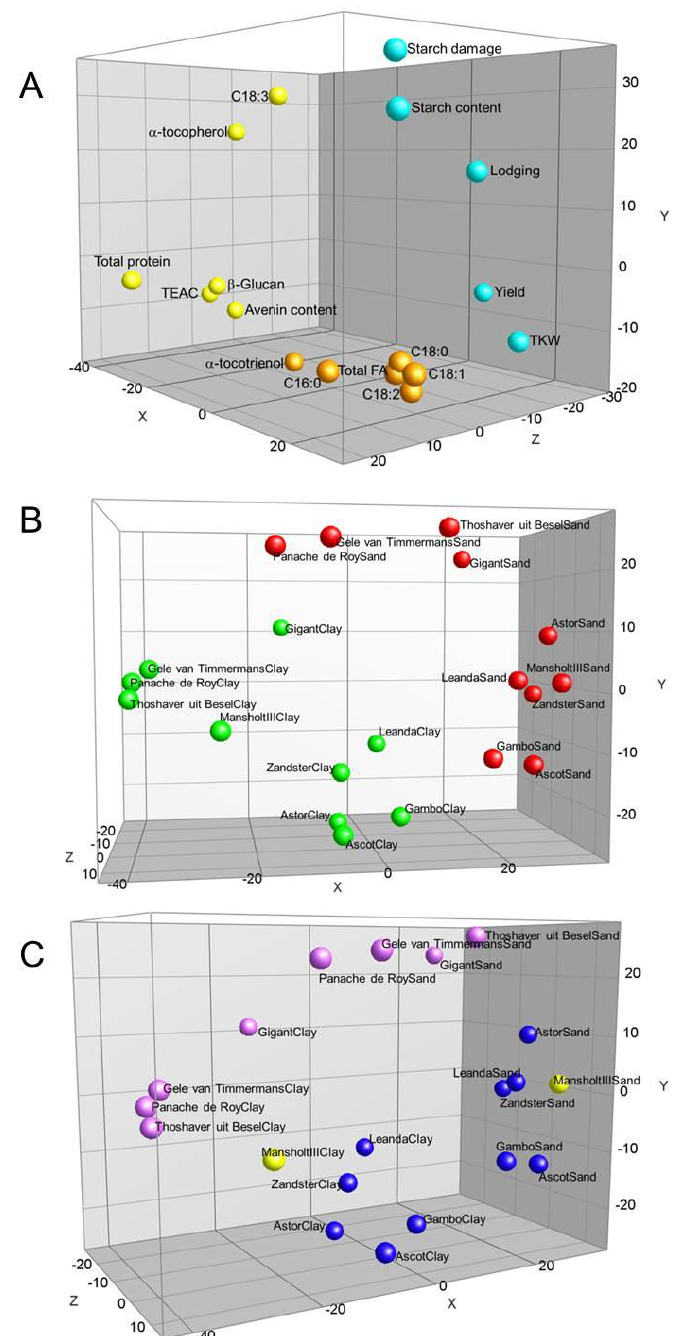
Figure 1. Principal component analysis 3D-plots of oat varieties and compounds. ( A ) Compound loading plot. Colors identify groups obtained from cluster analysis (Supplementary Figure S1); ( B ) Separation of oat varieties grown in sand and clay. Red dots are sand samples, green dots are clay samples; ( C ) The same as in (B), only slightly differently rotated and shows the separation of subsets of oat varieties showing contrasting compound contents when grown in either clay or sandy soil. PC1, X -axis, 32.0%; PC2, Y -axis, 21.1%; PC3, Z -axis, 14.3%.